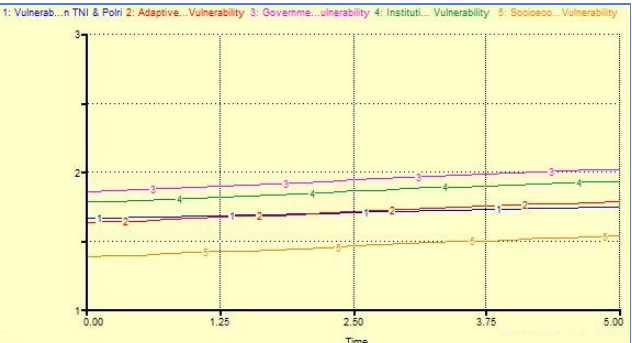
Fig. 7. Value of Relationship vulnerability index for TNI -POST post-1998 reformation era. Observation and simulation value of Relationship vulnerability index for TNI-Polri post-1998 reformation era. Result of Relationship Time Socio AC GC IV Vulnerability